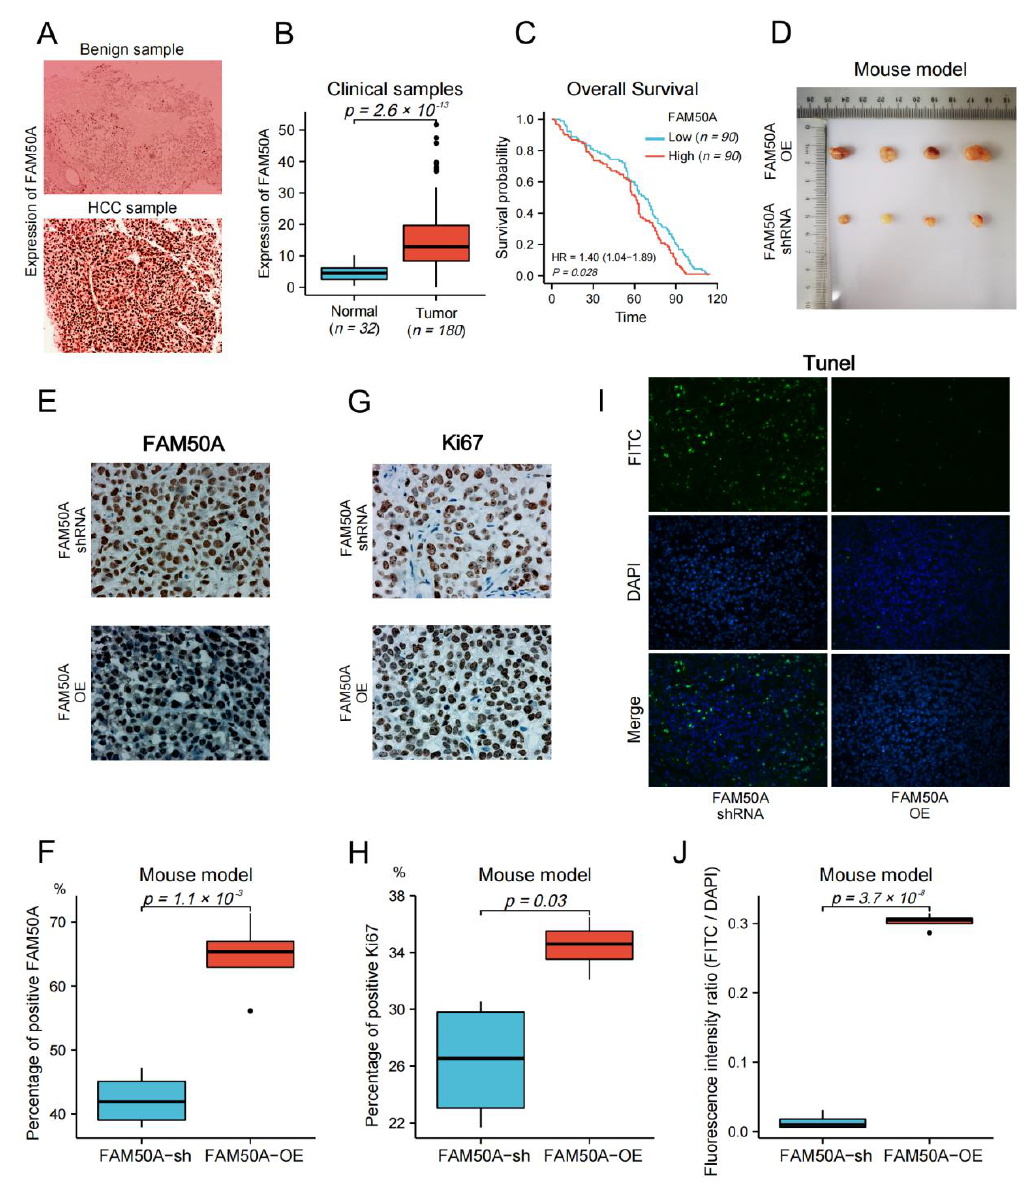
Figure 7. Effect of FAM50A on HCC in vivo. ( A ) The protein expression of FAM50A in benign liver tissues and HCC tissues was detected by IHC. ( B ) The software Image J was used to quantitatively analyze the expression of FAM50A in tissues. The expression of FAM50A in 180 HCC tissues was significantly higher than that in 32 benign liver tissues. ( C ) K-M analysis of 180 HCC patients showed that half of the patients with low FAM50A expression had better OS than the other half of the patients with low FAM50A expression. ( D ) Subcutaneous xenograft tumors formed in nude mice by FAM50A-shRNA-treated cells and FAM50A-OE cells. ( E , F ) The protein expression of FAM50A in subcutaneous xenograft tumors of nude mice was detected by IHC and analyzed by Image J. ( G , H ) The expression of Ki67 in subcutaneous xenograft tumors of nude mice was detected by IHC and analyzed by Image J. ( I , J ) TUNEL intensity in subcutaneous xenograft tumors of nude mice was measured by IF and analyzed by Image J.